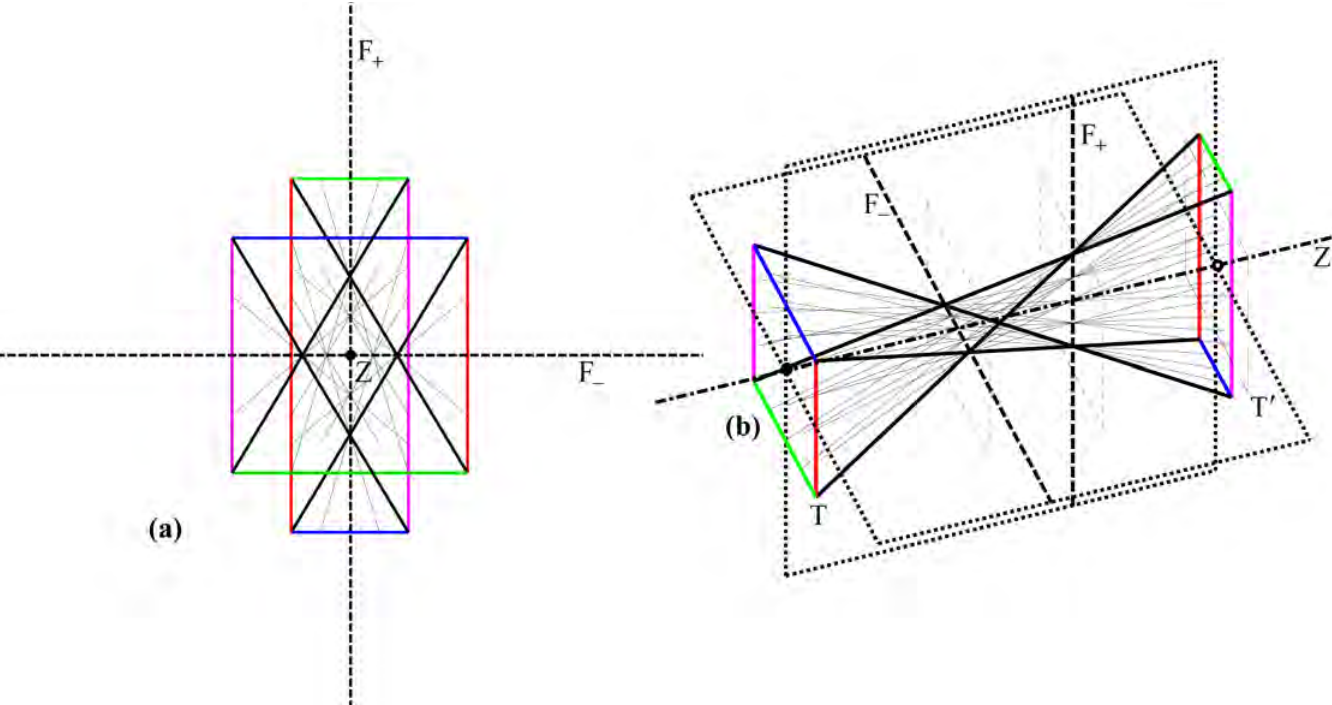
Figure 10 A pencil with divergency 4/ JIM +−= D at T. The pencil is conventional. The orthogonal line foci define the inter - val of Sturm. (b) azimuth °− 20 20 °− 20 , elevation 42 °− 20